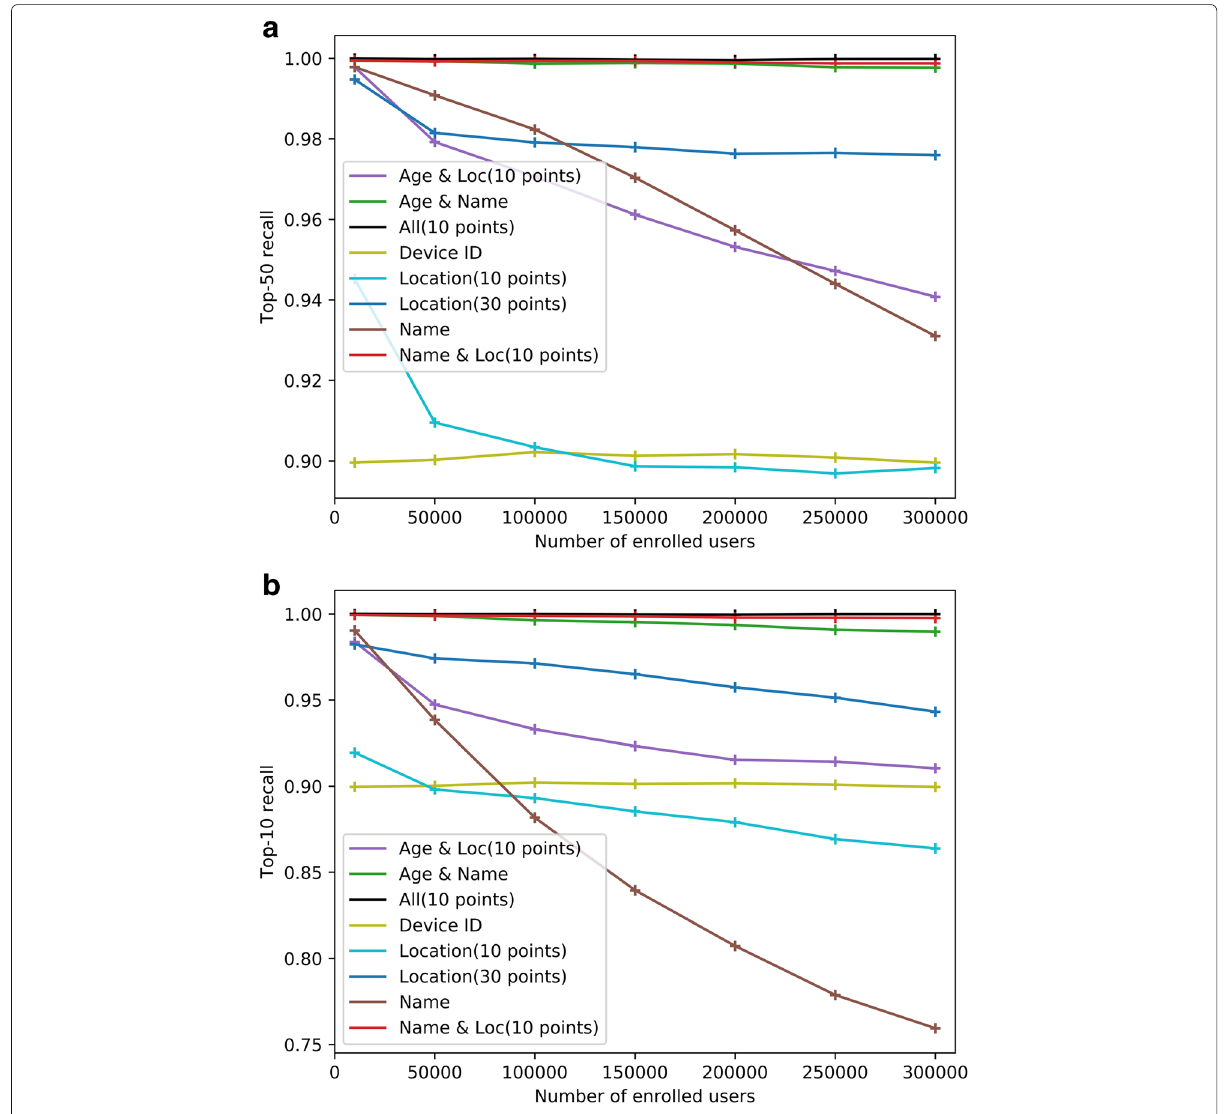
Fig. 7 Top-k recall for investigated strategies